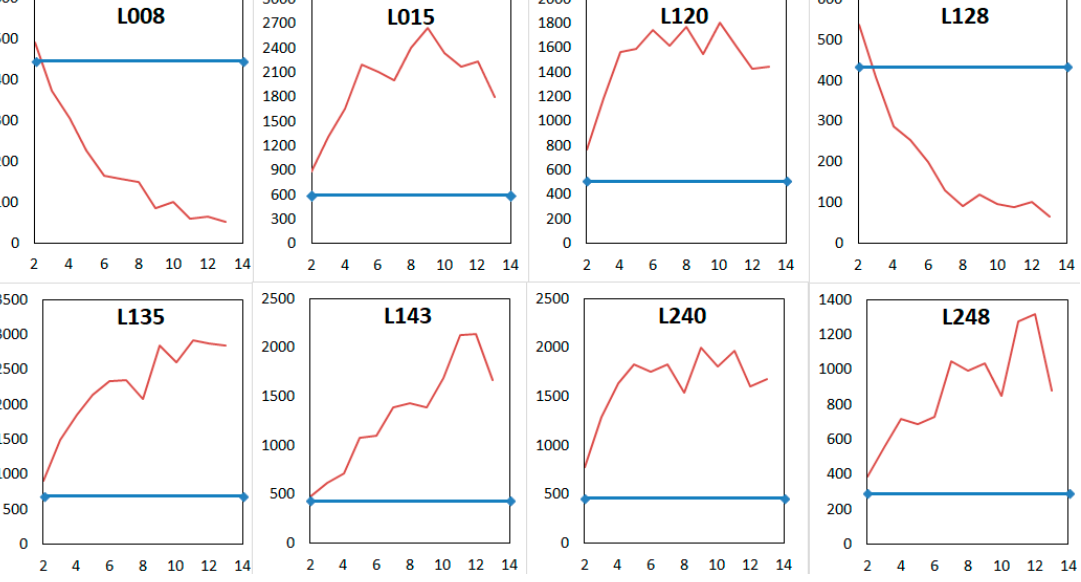
Figure 16. Variations of LBP feature vector components with grid spacing in uniform-grid sampling. The x -axis gives the values of δ . The y -axis gives the range of values of an LBP feature shown in the chart title.